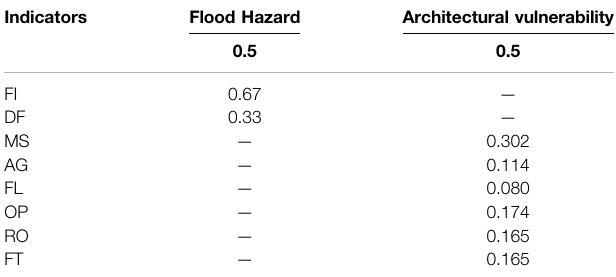
TABLE 6 | Weights calculated by AHP.